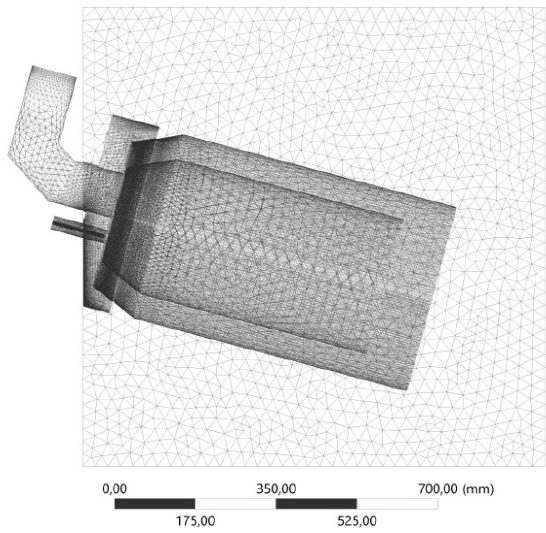
Figure 11. Mesh of the mathematical model.